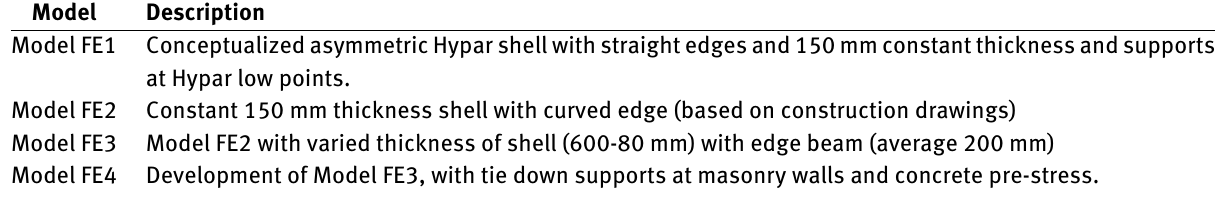
Table 2: Description of FEA models Model